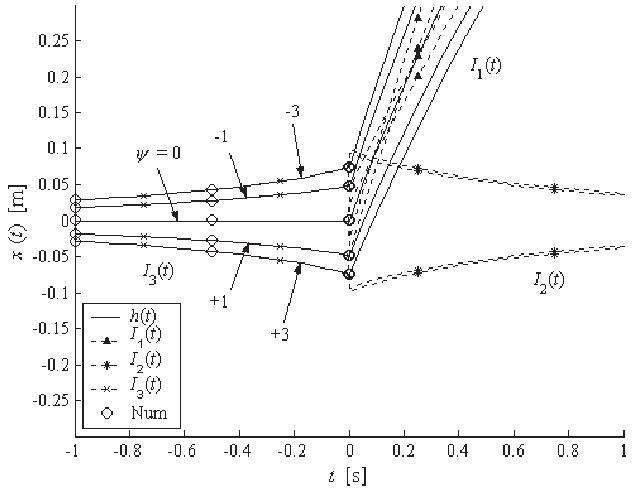
Fig. 8. Impulse response for the complex damped SDOF system: non causality region.